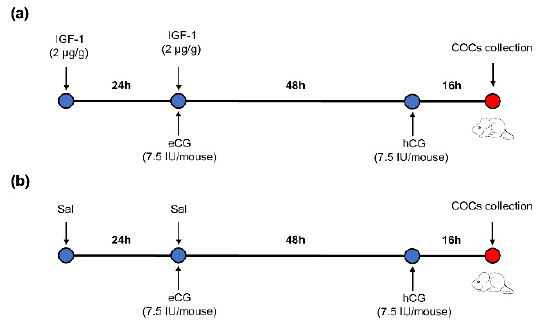
Figure 1. The protocol of IGF-1 administration during mouse superovulation. ( a ) IGF-1 treatment group; ( b ) Control group.